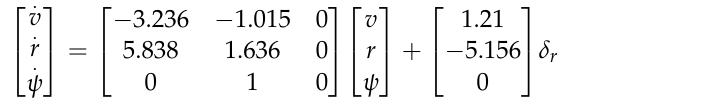
Y 0 Figure 4. Autonomous underwater vehicle’s depth plane motion.